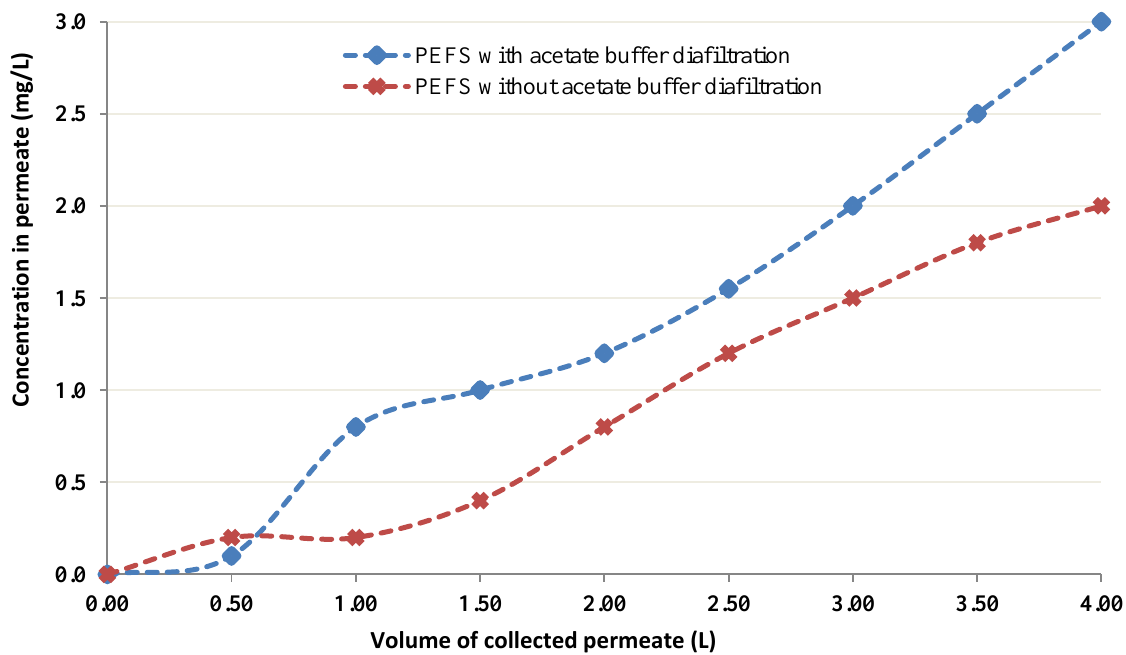
10 of 17 Figure 8. Permeation curve illustrating CEFP with 6 g/L chitin (volume of 20 mg/L Cobalt was 3 L, and pH = 4). 3.2.5. CEFP with 20 g/L Chitin at pH = 2.5 Such an experiment was performed to evaluate the impact of an ultra-elevated level of chitin on the CEFP and retention of Co. To solubilize elevated levels of chitin in the acetic acid, a lower pH (2.5) was necessary and, hence, kept. Figure 9 illustrates the details of the CEFP using 20 g/L chitin, and shows that a very low concentration was detected in the permeate. Also, the volume of permeate gathered was minimal, which signifies that the amount of processed Co solution was also small. Following 3 hrs, only 0.3 L was treated because of a decline in permeate flux for the elevated viscosity of the chitin solu- tion.